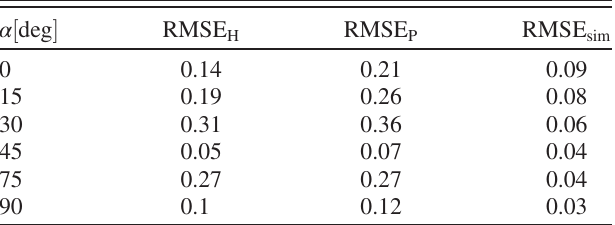
TABLE II. RMSE between measurements and simulation as well as between both simulation models for different applied field angles. The RMSE is calculated using magnetic flux density relative to the mean of all sensors. RMSE is the RMSE between H measurements and simulation assuming homogeneous field, RMSE denotes RMSE between measurement and simulation P with perpendicular field, and RMSE is the RMSE between sim simulations.